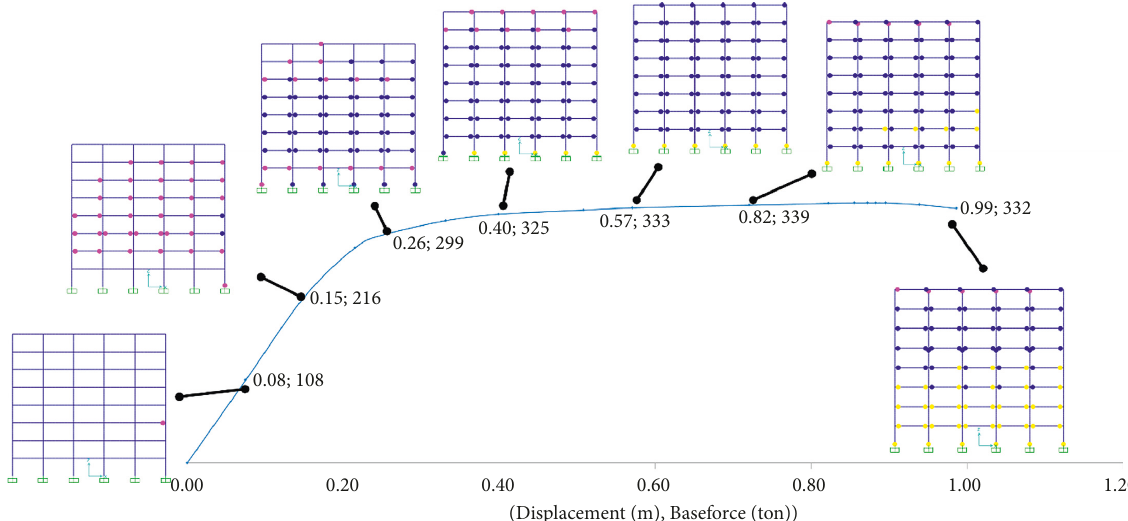
Figure 14: Pushover graph of an 8-story frame designed by the energy